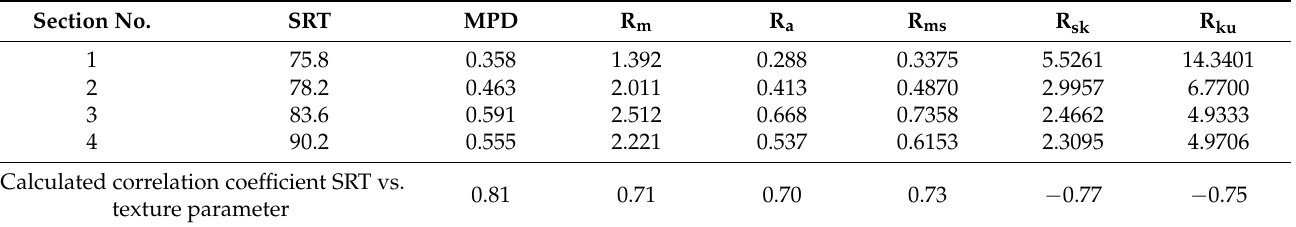
Table 6. Correlation analysis of friction vs. texture